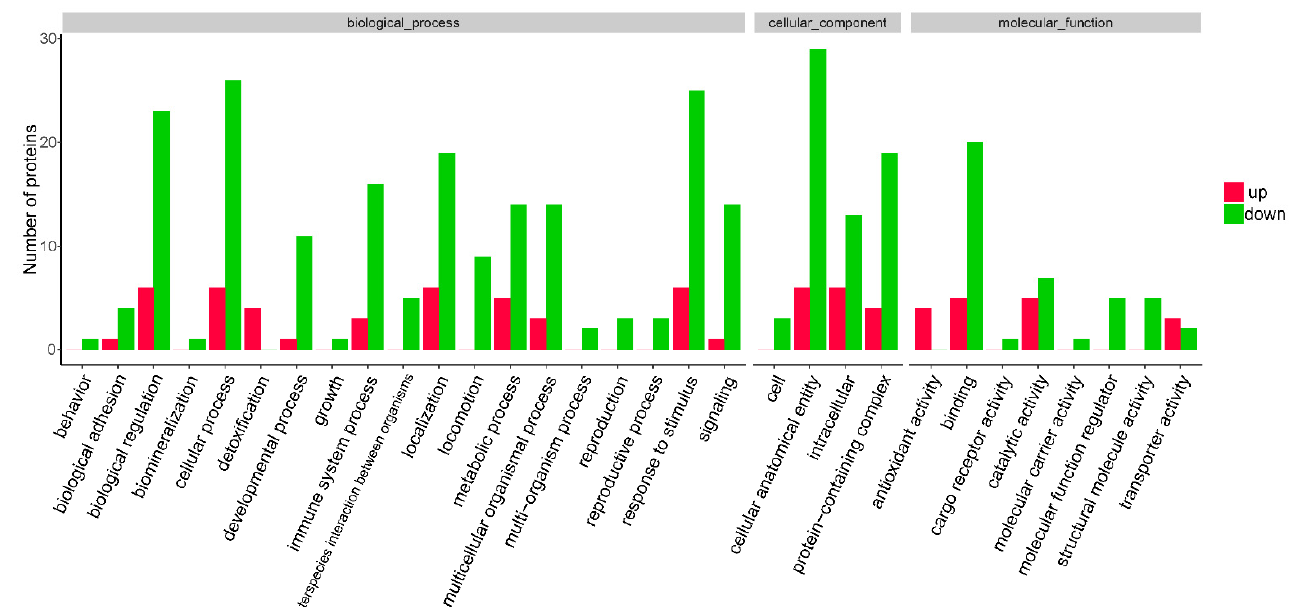
Figure 3. Gene ontology (GO) functional annotation and enrichment analysis of 35 differentially expressed proteins (DEPs) detected between the experimental and control groups. (A) GO functional annotation analysis of 35 DEPs. Up represents proteins that are upregulated between the experimental and control groups; down, proteins that are downregulated.